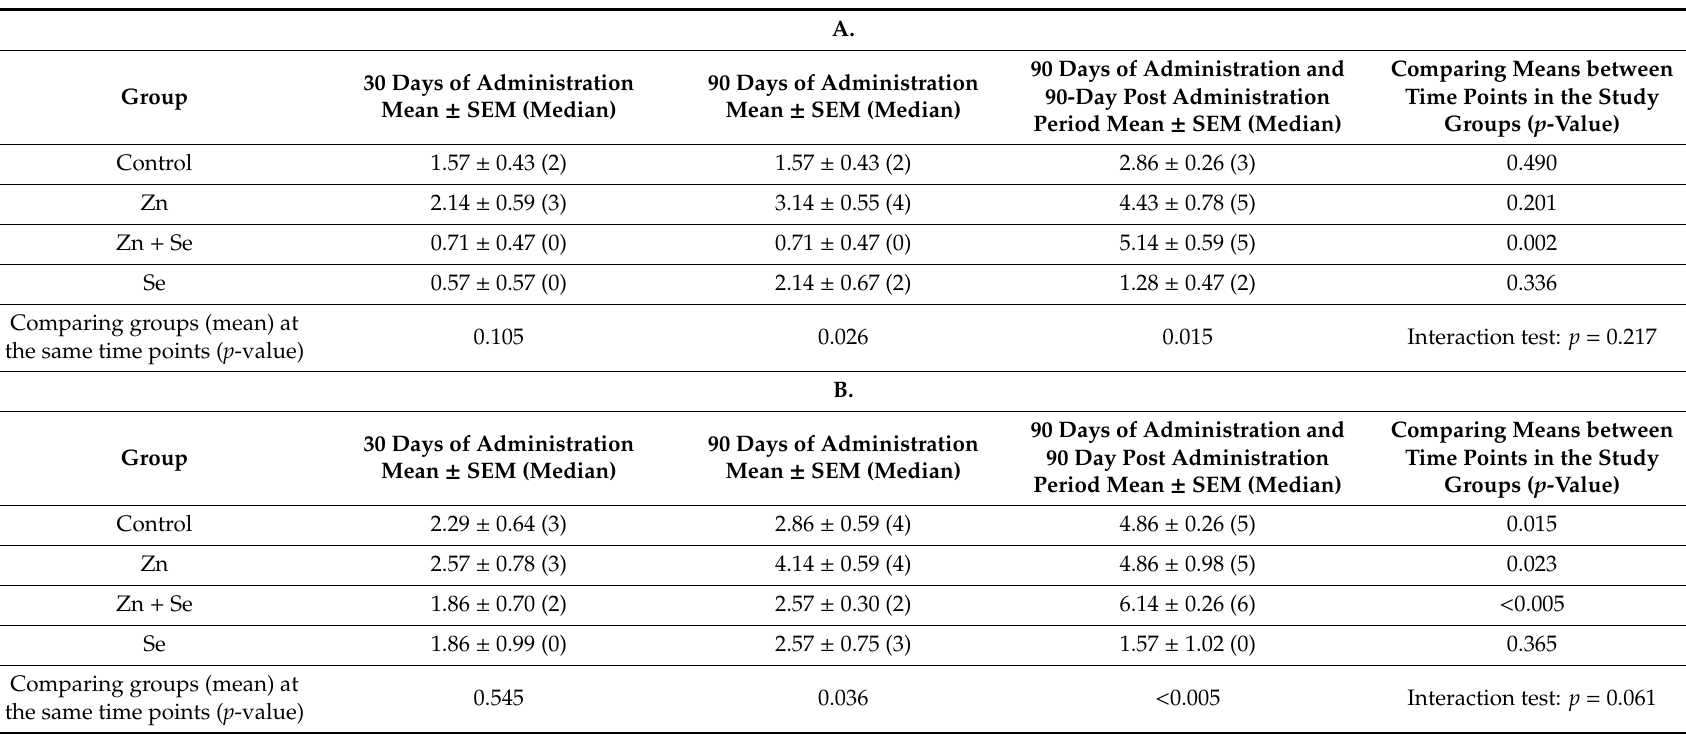
Table 2. Means and medians of TS (total score) values for the rat prostate lobes (A, ventral; B, dorsolateral) after 30 and 90 day administration of Zn and / or Se, and after 90 days exposure with an additional 90 day post-administration